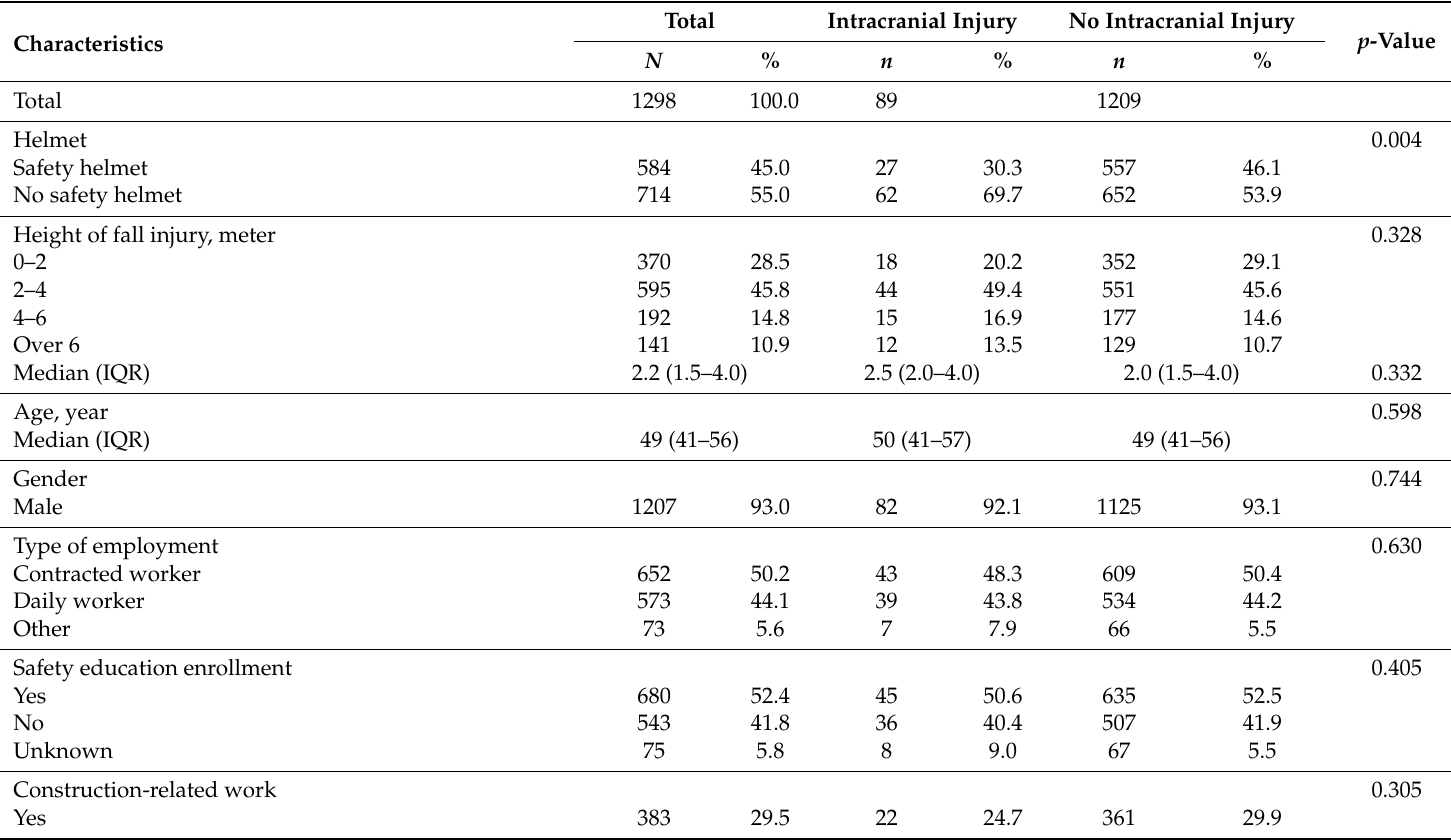
Table 2. Demographic findings of study population by intracranial injury